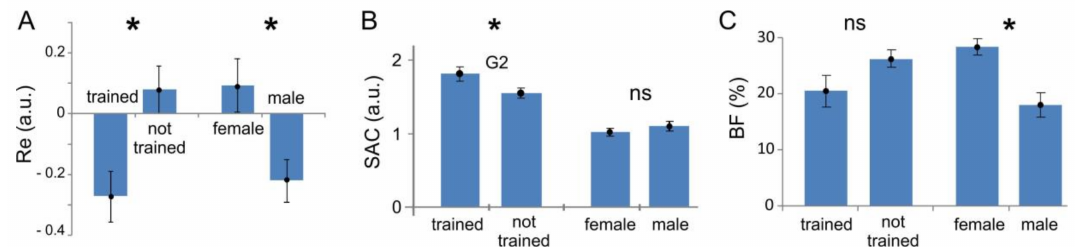
Figure 6. Assessment of latent factors influencing the performance of the sEMG-interface (mean values and standard errors are shown; stars mark statistically significant changes, p < 0.05; ns stays for not significant). ( A ) Performance index (relative error), Re; ( B ) Synergist–antagonist coefficient, SAC; ( C ) Body fat index, BF.